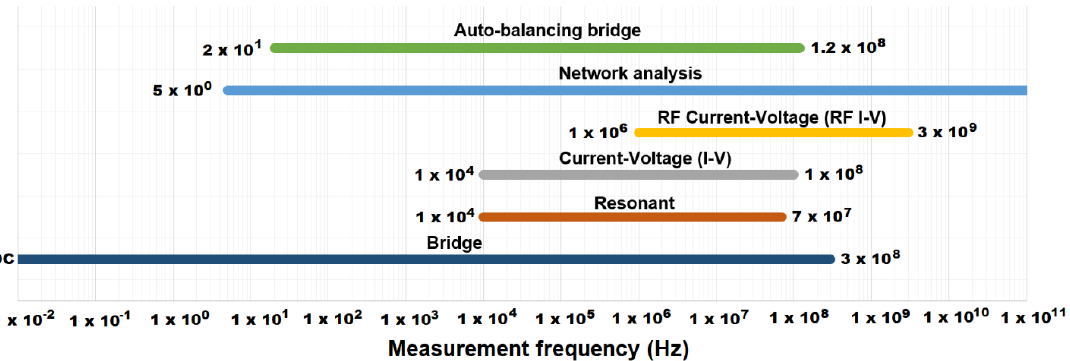
Figure 1. Frequency measurement range of six common impedance measurement methods [11].